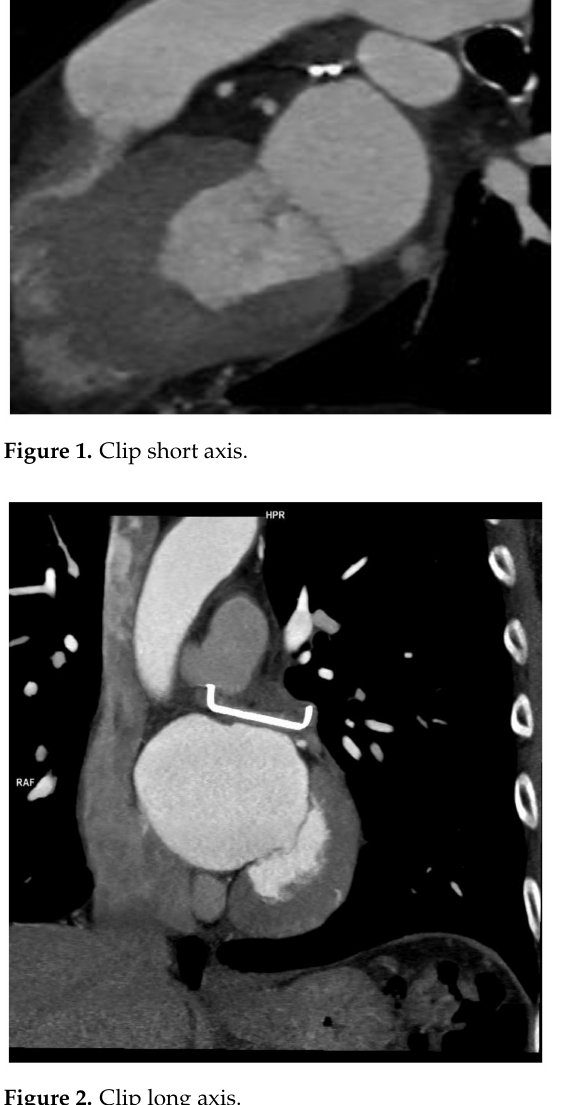
Figure 2. Clip long